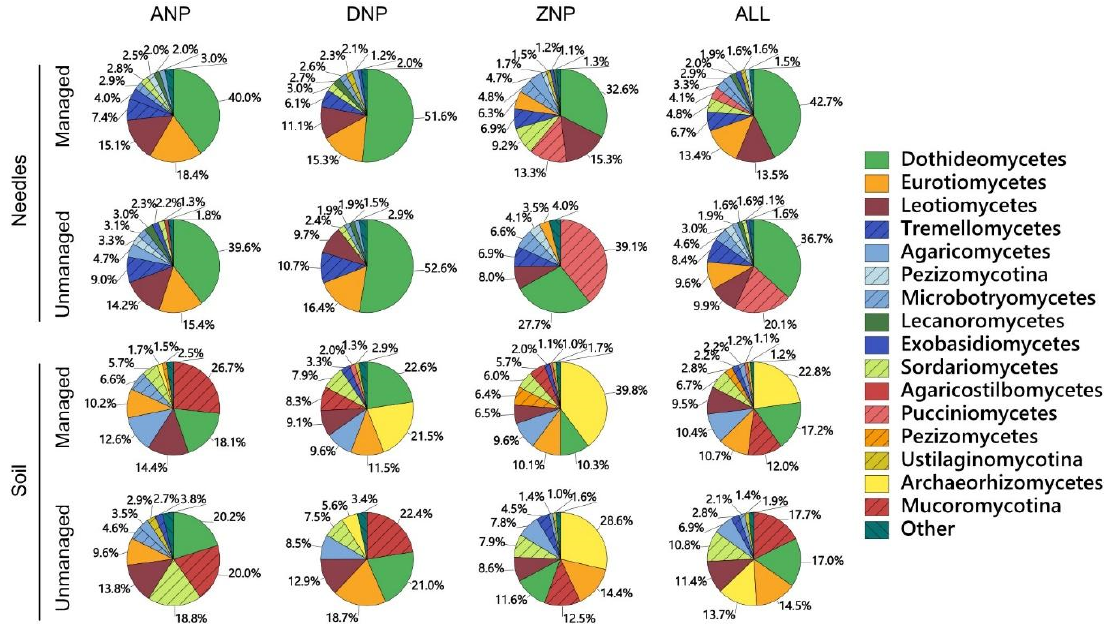
Figure 3. The relative abundance of different fungal classes in living needles and soil from managed and unmanaged Pinus sylvestris forest stands at the Aukštaitija National Park (ANP), Dzūkija National Park (DNP) and Žemaitija National Park (ZNP). In ALL, data from different sites is